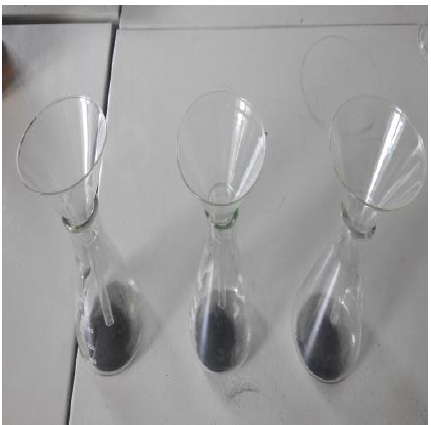
Figure 6. Specimens.